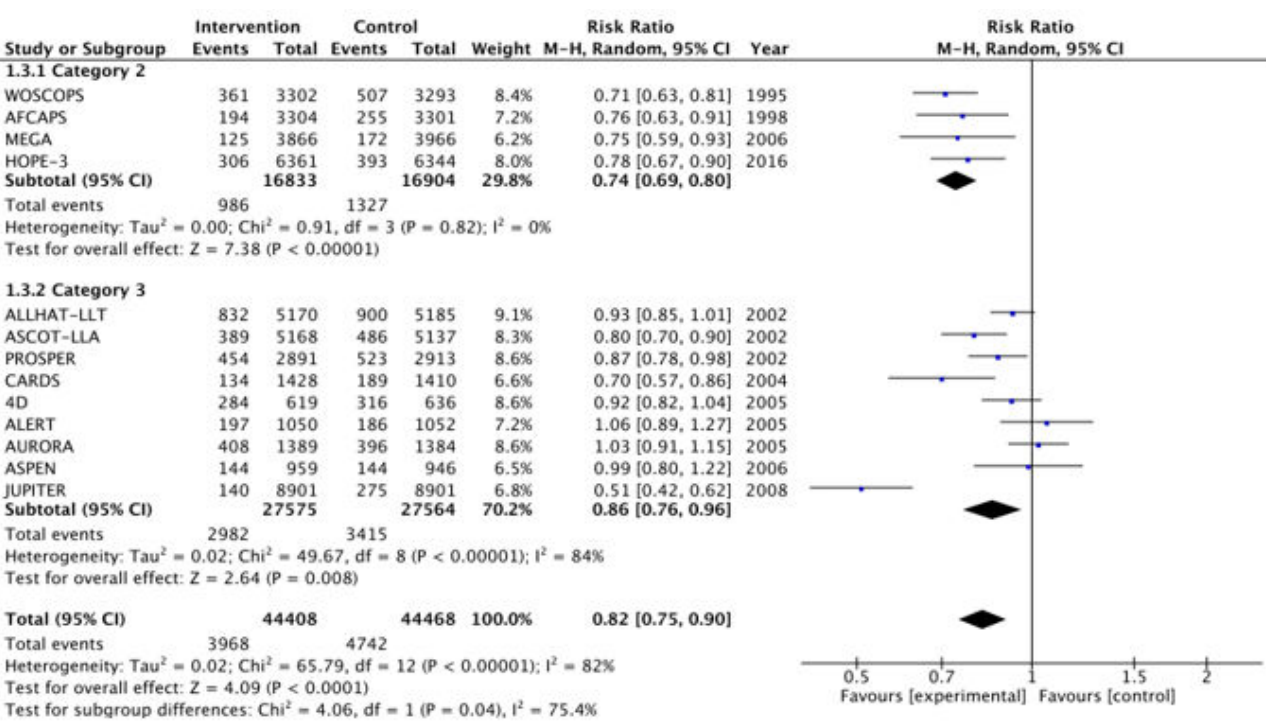
Figure 6. Relative risk across Category 2 and 3 studies for the tertiary outcome of all CVD events combined. Heterogeneity across studies was high, so random effects were used for the meta-analysis (Heterogeneity: Chi 2 = 65.79, p < 0.001, I 2 = 82%).